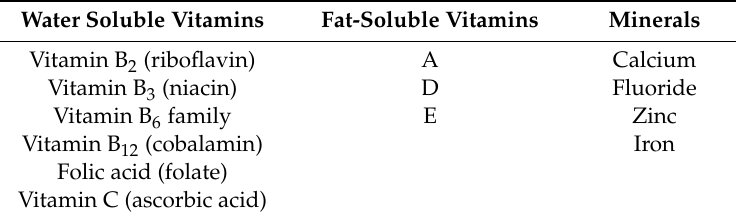
Table 2. Nutrients associated with healthy mucous membranes